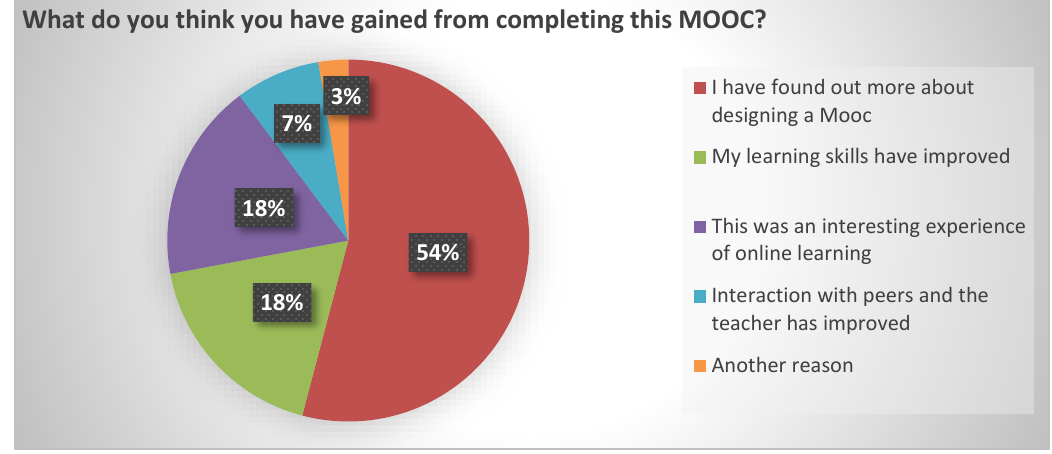
Figure 4. Percentages of students’ responses concerning the MOOC learning outcomes. Satisfaction with student-teacher interaction via Avatar technology. The question; how satisfied or dissatisfied were you with the interaction you achieved with the teacher using the Avatar instead of the video of the presenter herself? It is clear from Table 4 that almost half the students were “Satisfied” with the level of interaction achieved with their teacher using the Avatar tool and more than a third were “Very Satisfied.” In contrast, just 13% were “Neutral” and only 3% were “Dissatisfied.”